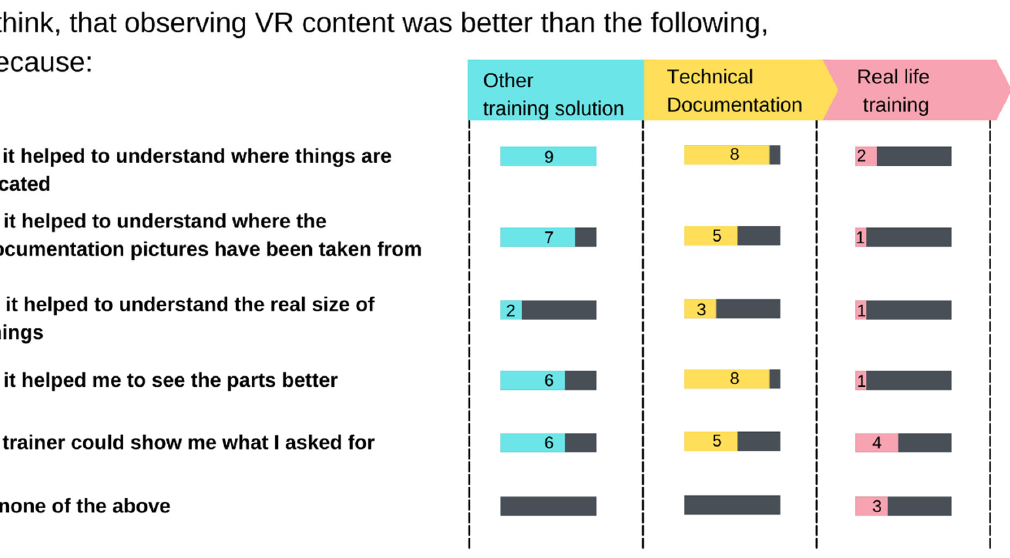
Figure 8. Comparison of asymmetric VR ‐ based training to other available solutions. The numbers in the figure show how many experts agreed with the mentioned statement.